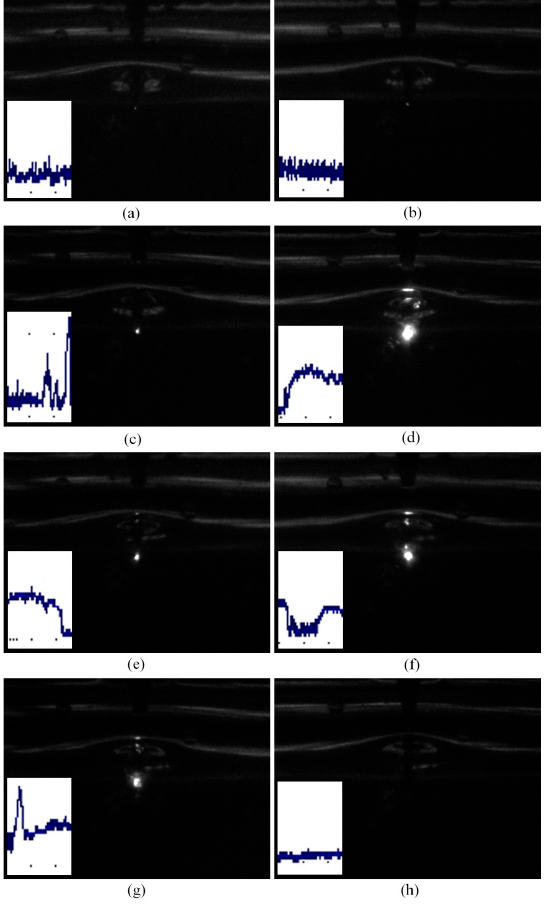
Figure 6. Discharge images and the corresponding discharge current signals in ECDM at different times. ( a ) 0 μ s, ( b ) 100 μ s, ( c ) 200 μ s, ( d ) 300 μ s, ( e ) 400 μ s, ( f ) 500 μ s, ( g ) 600 μ s, ( h ) 700 μ s. times. ( a ) 0 µ s, ( b ) 100 µ s, ( c ) 200 µ s, ( d ) 300 µ s, ( e ) 400 µ s, ( f ) 500 µ s, ( g ) 600 µ s, ( h ) 700 µ